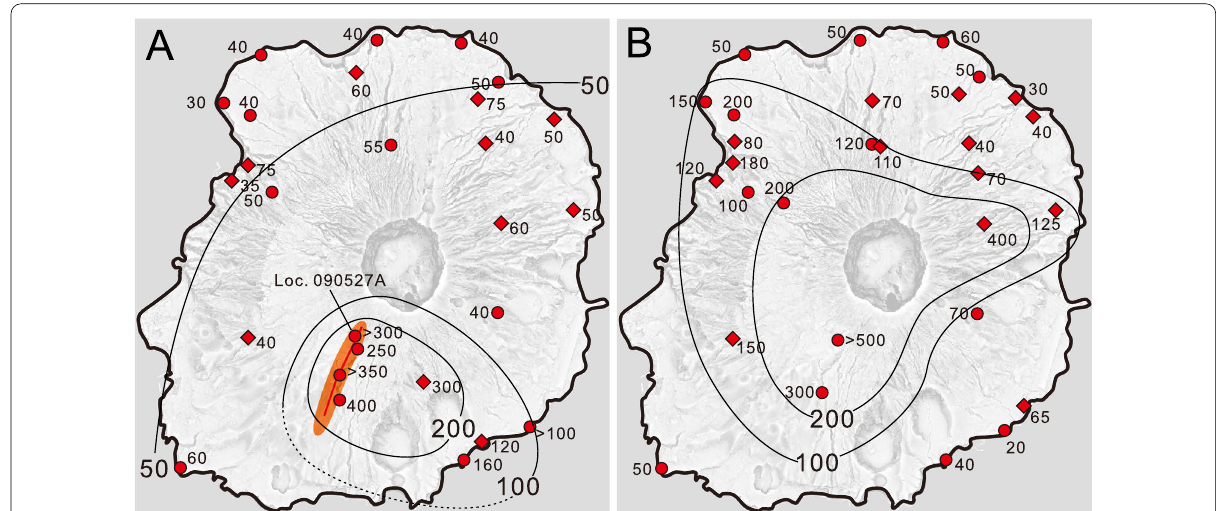
Fig. 3 Distribution of the Hatchodaira scoria fall deposit ( A ) and the Hatchodaira ash layer ( B ). Orange area in A shows the approximate distribution of the welded spatter. Circle symbols show the field measurement by this study, and diamond symbols show the data shown by Tsukui and Suzuki